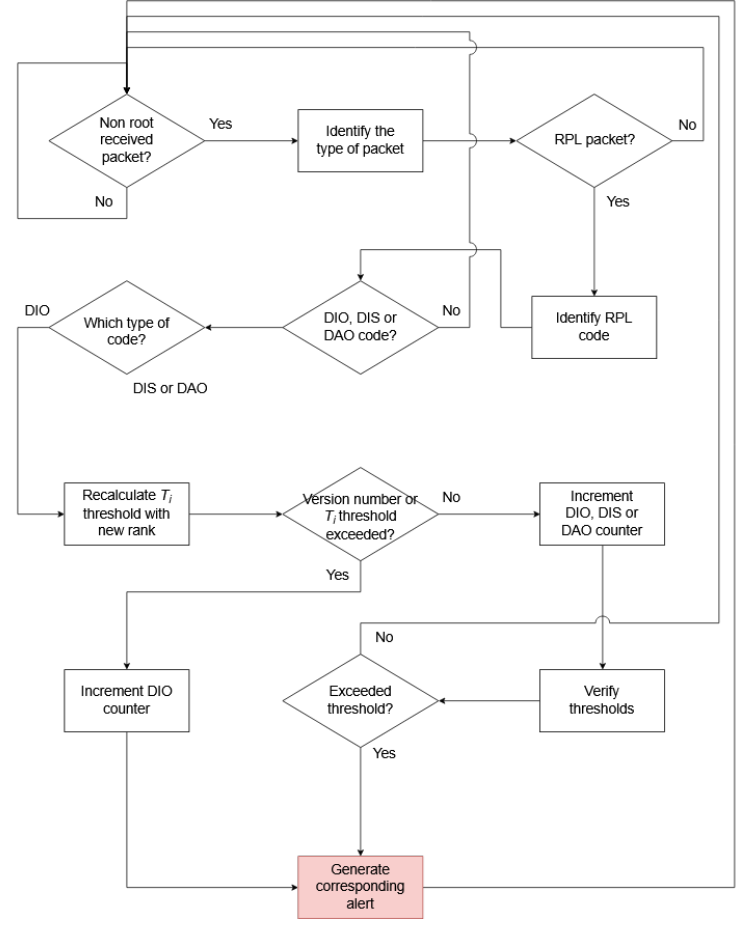
Figure 3. IDS detector